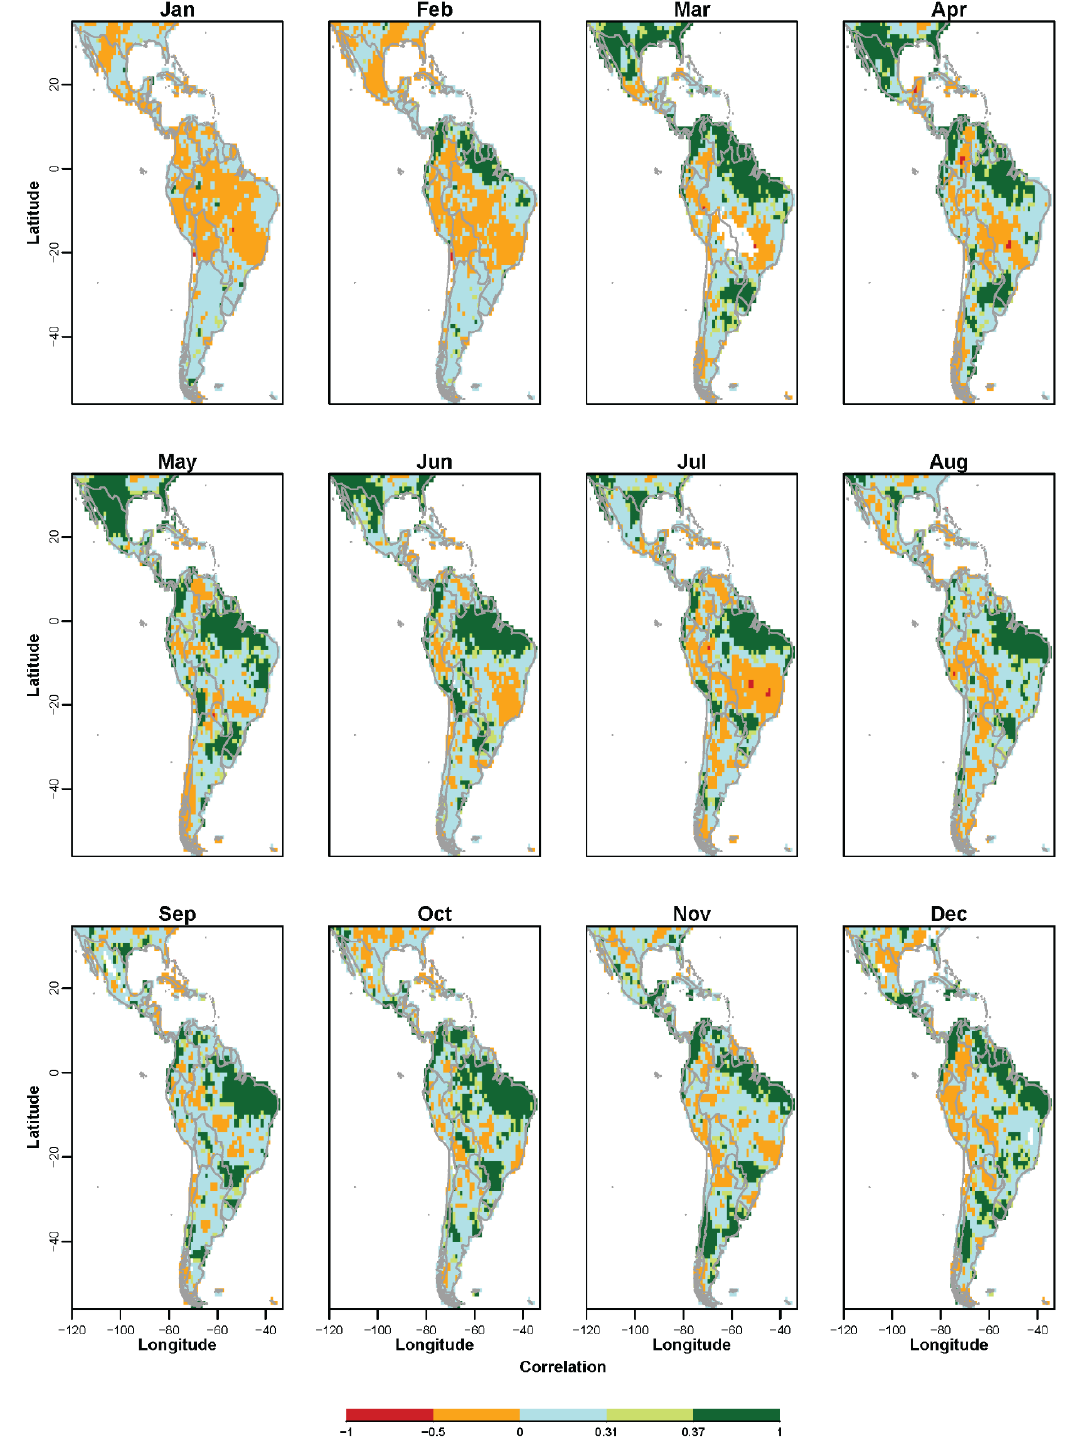
Figure A1. Monthly correlation of the observed and forecast SPI at 6-months lead time (SPI6) (using the mean of the ensemble) for the hindcast period (1981–2010). Values are indicated in the color bar: 0.31 (0.37) is statistical significant at 10% (5%) significance level.